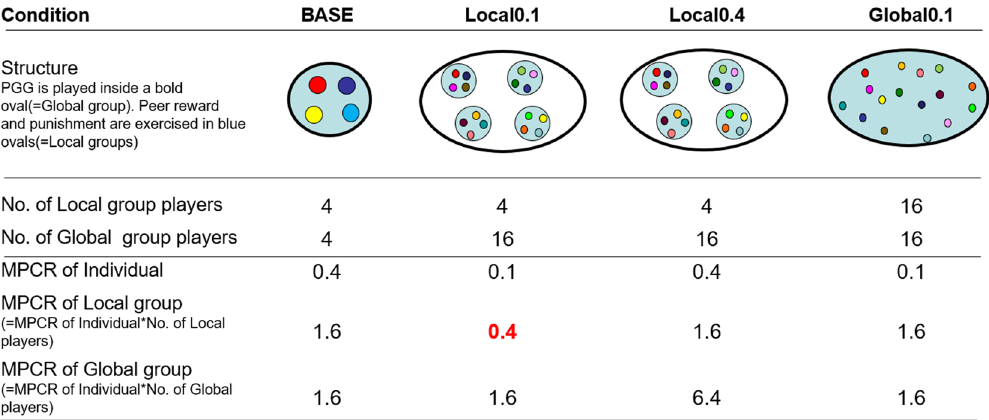
Figure 1. Experimental settings and MPCR for each